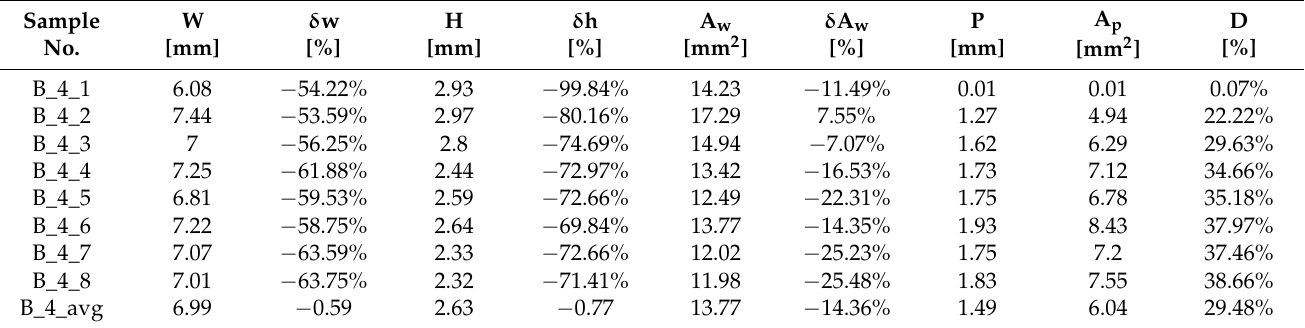
Table A9. Measurements of dimensional features of 4th parameter set of Wire B—wire feed